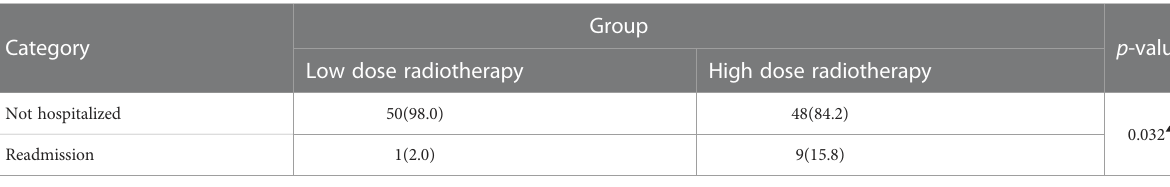
TABLE 4 Clinical outcomes of pneumonia after radiotherapy.